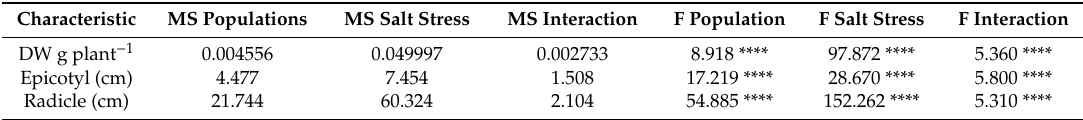
Table 4. The two-way ANOVA applied to growth parameters for seven populations of M. ciliaris ( Pop1, Pop2, Pop3, 306, 355, 667, 773 ), compared to one population of M. intertexta ( M. int ) and one population of M. scutellata ( M. scut ). The means are averages of 25 plants. Characteristic MS Populations MS Salt Stress MS Interaction F Population F Salt Stress F Interaction DW g plant − 1 0.004556 0.049997 0.002733